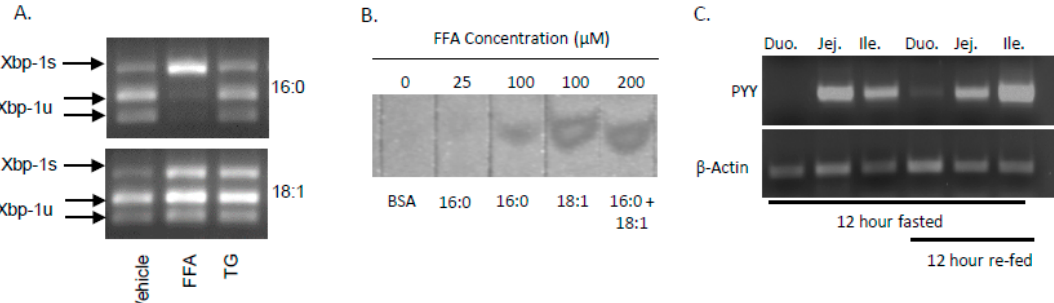
Figure 5. SFA as FFA vs. TG and its effect on Xbp1s and TG synthesis. ( A ) STC-1 cells were treated with MUFA (18:1) or SFA (16:0) as FFA or TG and Xbp1s and Xbp1u mRNA levels were measured by PCR. SFA induced Xbp1s only as FFA and no effect was observed with MUFA or TG (SFA or MUFA) on splicing. ( B ) MUFA enhances the amount of TG synthesis as shown by density of TG bands on TLC plates. ( C ) MUFA is absorbed in the proximal small intestine (early in digestion) compared to distal absorption of SFA, whereas PYY expression is in the distal region. This evidence suggests that (1) non-esterified saturated fatty acids are responsible for inducing Xbp1s in the gut, (2) MUFA’s enhance the rate of TG synthesis (i.e., FFA disappearance, and (3) the earlier FFA’s are absorbed (i.e., proximal SI), the less likely they are to reach the distal SI where PYY is expressed.